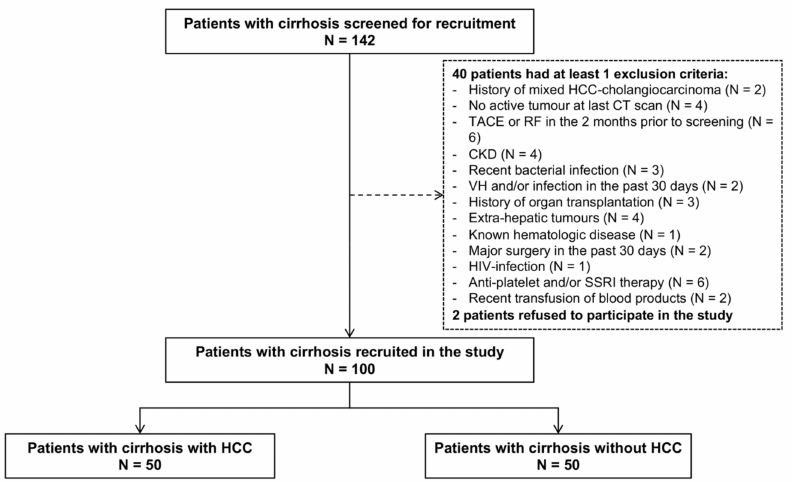
Figure 1. Flow-chart of the study. Legend: CKD: chronic kidney disease; VH: variceal haemorrhage; SSRI: selective serotonin reuptake